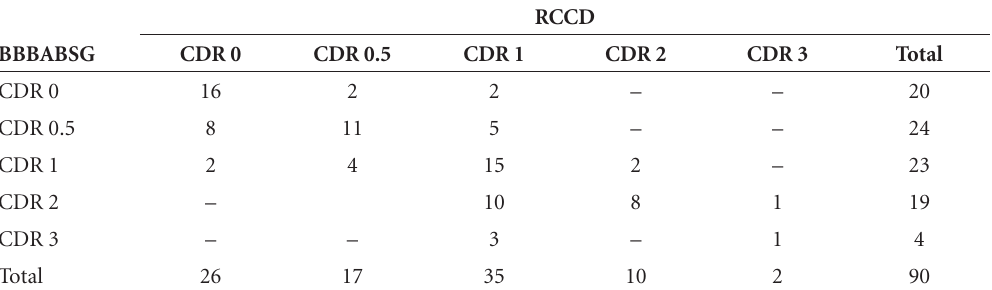
Table 2. Classifications according to the CDR scale by the Reference Center for Cognitive Disorders (RCCD) and by the Brain Bank of the Brazilian Aging Brain Study Group